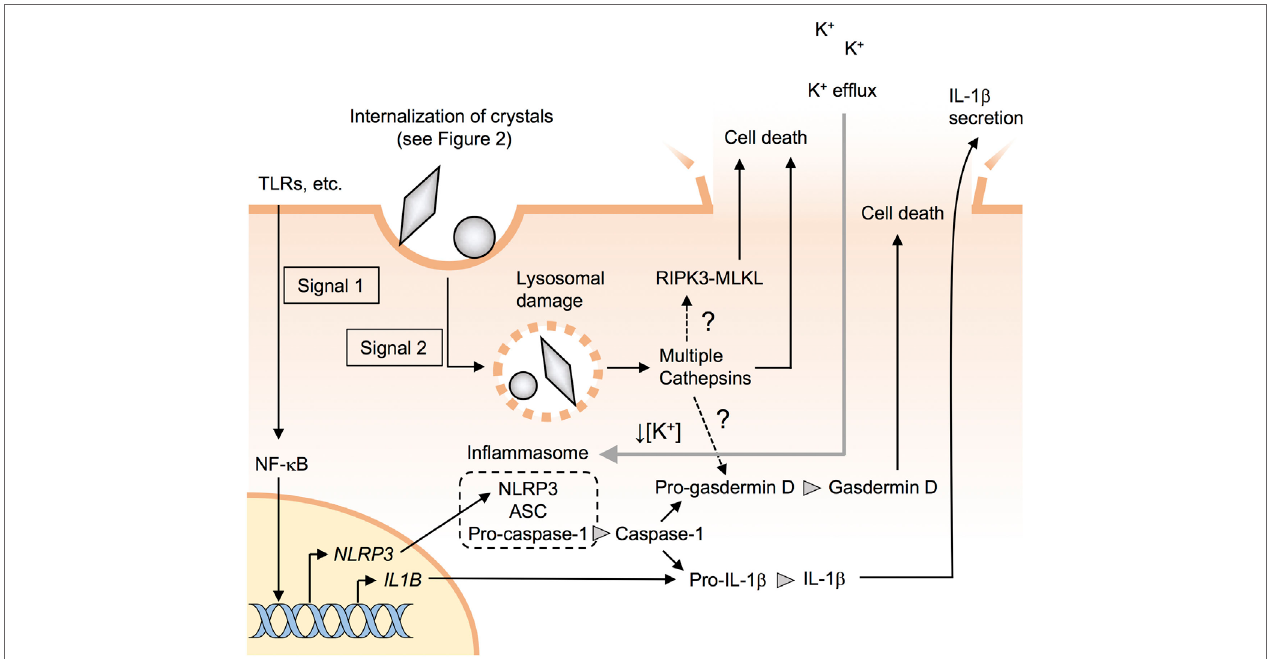
FigURe 1 | Particle-induced NLRP3 inflammasome activation and cell death. Signal 1 induces pro-IL-1 β along with NLRP3 through the nuclear factor-kappa B (NF- κ B) pathway. Signal 2 causes lysosomal damages and stimulates the assembly of a complex of multiple proteins including NLRP3, ASC, and procaspase-1, resulting in the formation of inflammasomes. Active caspase-1 processes pro-IL-1 β and pro-gasdermin D to mature IL-1 β and gasdermin D. Lysosomal damage results in the release of the lysosomal enzyme cathepsins, which may induce NLRP3 inflammasome-independent pyroptotic cell death. Receptor-interacting serine/ threonine kinase-mixed-lineage kinase domain-like protein (RIPK3-MLKL) pathway is involved in crystal-induced necroptosis in epithelial cells but not in